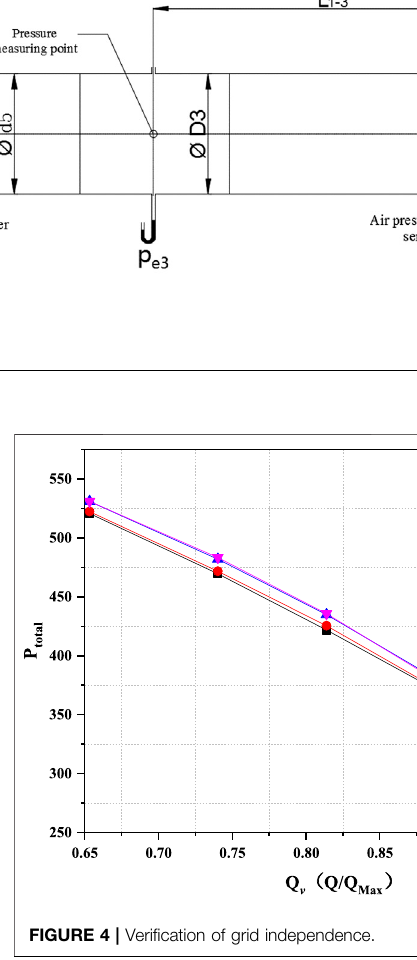
TABLE 3 | Boundary conditions and calculation convergence criteria.